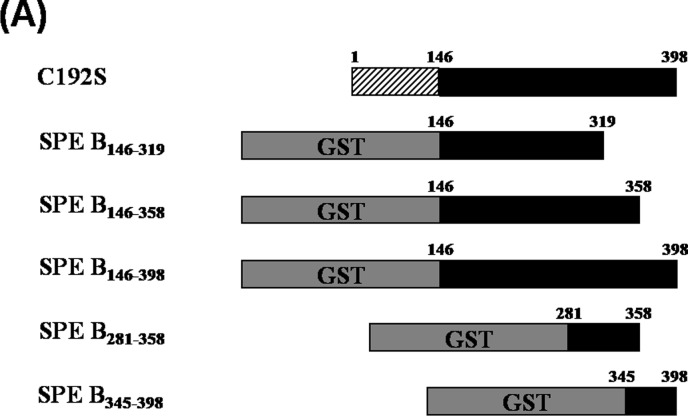
Truncated recombinant SPE B mutants and synthetic peptides.Schematic diagrams of different recombinant SPE B fragments, including SPE B146–319, SPE B146–358, SPE B146–398, SPE B281–358, SPE B345–398, and C192S. The cloning and expression of the different speB gene segments were described in the Materials and Methods. C192S, which contained a mutation at the active site Cys-192 of SPE B, represents a complete loss of protease activity mutant.